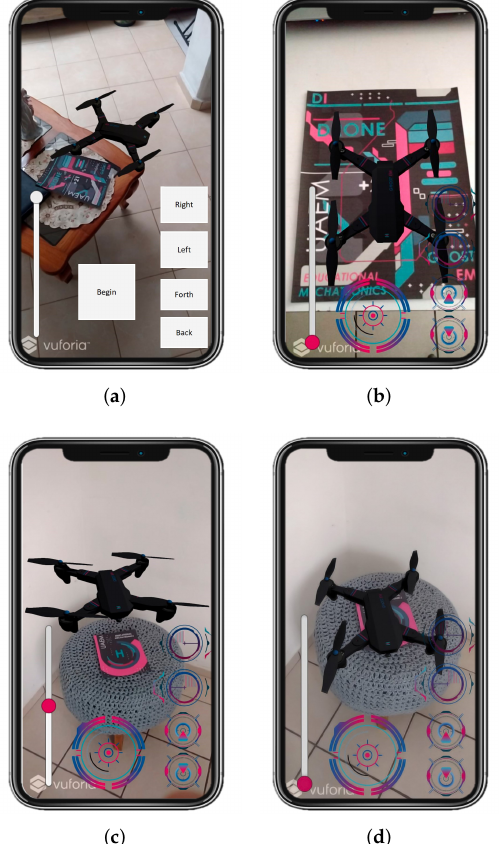
Figure 19. Different views of the application tests. ( a ) Design of the drone environment in augmented reality using Unity. ( b ) Display of image on device’s buttons in the design for Android devices and integration of the buttons. ( c ) Unit tests of each of the buttons and their operation. ( d ) Prototype functionality